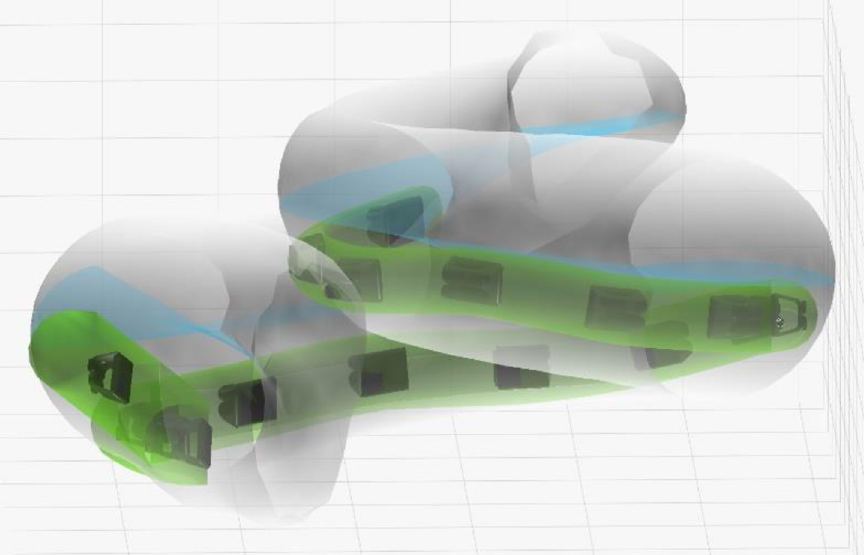
Fig 2. 3D visualization of cochlea and electrode position from subject ID 28, showing a potential soft contact with the basilar membrane and some slight buckling in the middle part of the